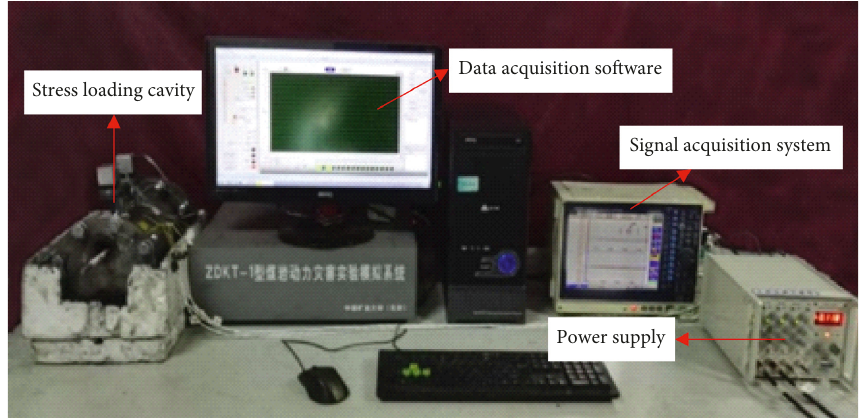
Figure 2: Coal roadway excavation simulation experiment